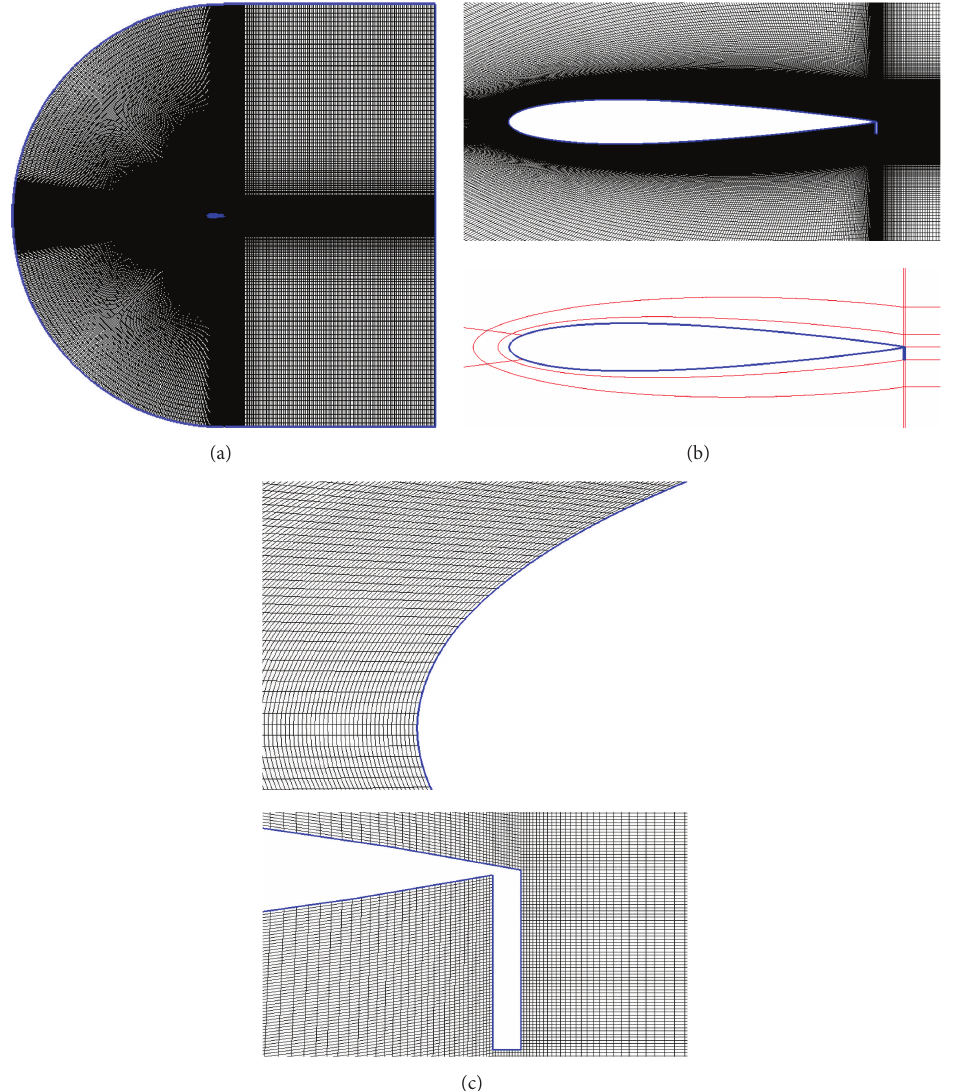
Figure 1: (a) Entire domain of the grid used. (b) Near surface grid and blocking near the airfoil surfaces. (c) Boundary layer elements near the leading and trailing edges of the